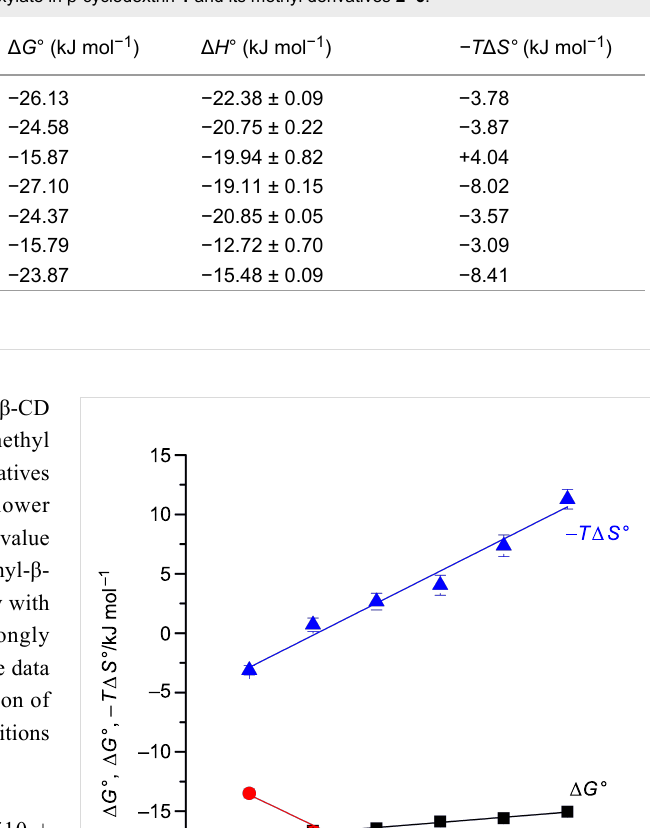
Table 2: Thermodynamics of the inclusion of adamantane-1-carboxylate in β -cyclodextrin 1 and its methyl derivatives 2 – 6 .